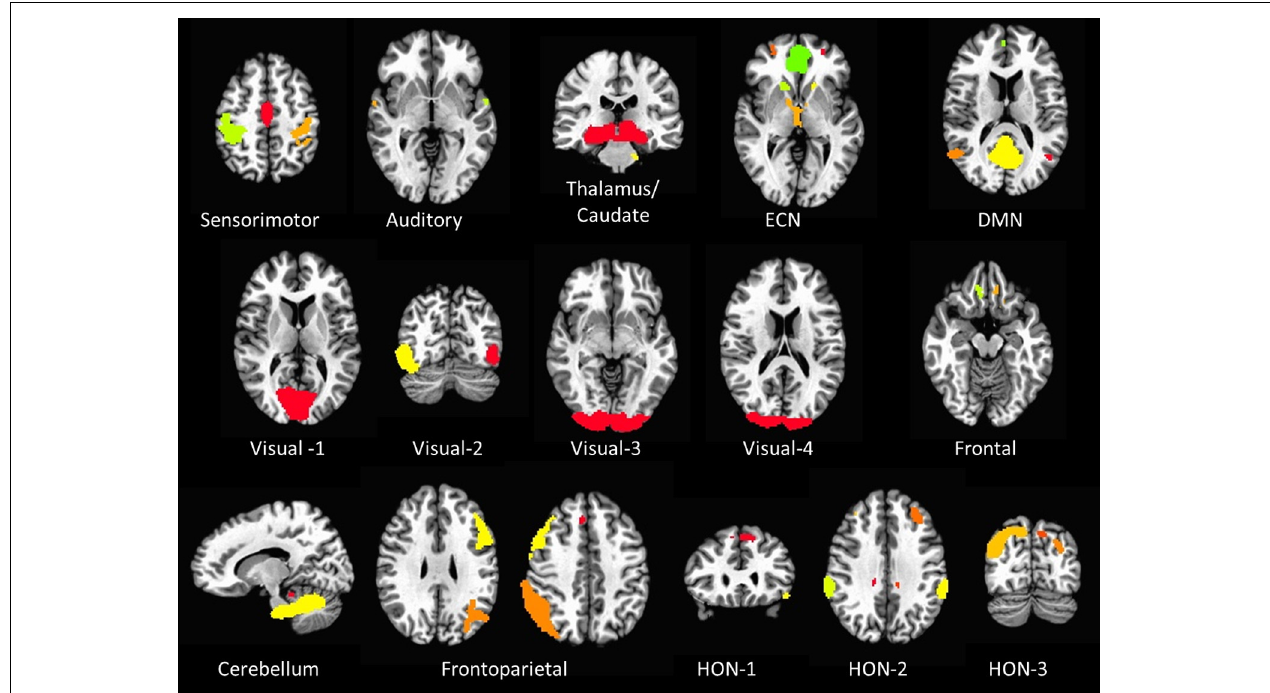
FIGURE 1 | The 16 resting state networks and their corresponding node regions. Resting state networks were selected and thresholded from a 20-component ICA decomposition of task fMRI data from the BrainMap